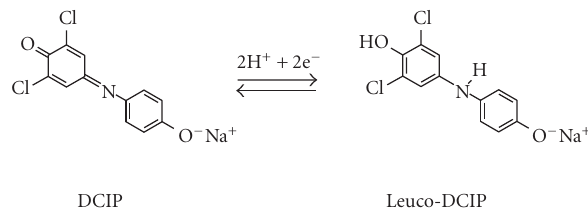
Figure 1: The structures of the sodium salt of DCIP (left) and its reduced product,